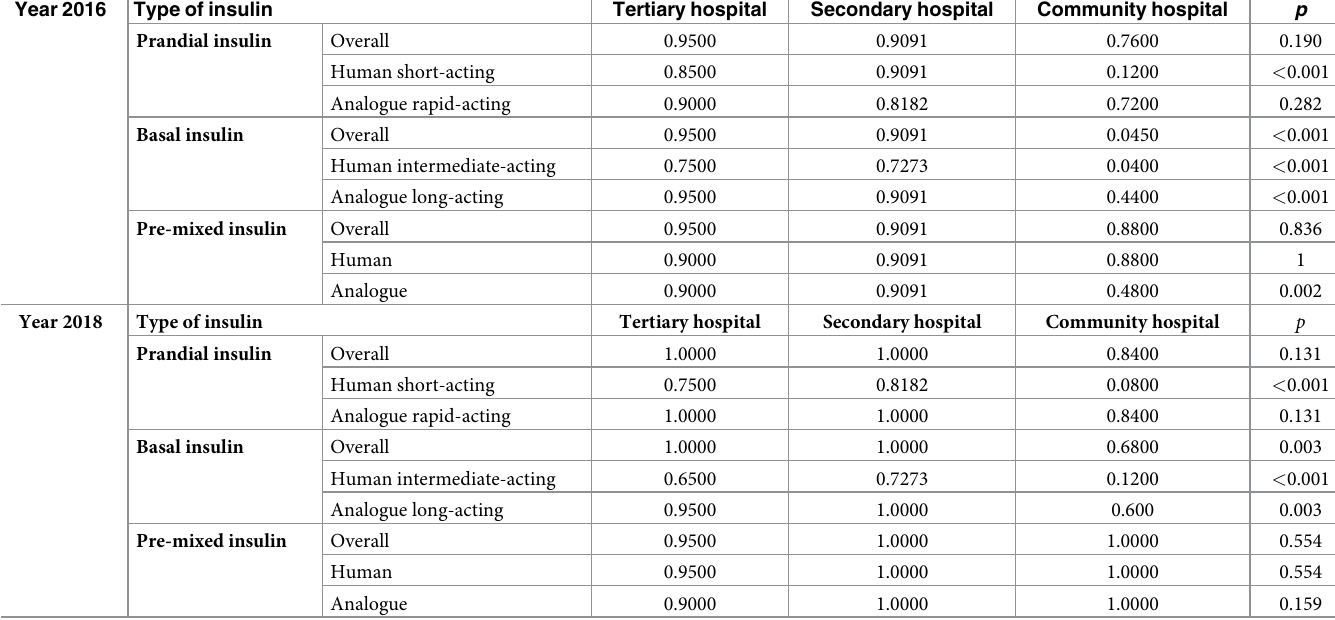
Table 6. Mean availability (%) of insulin products in different-level of pharmacies.